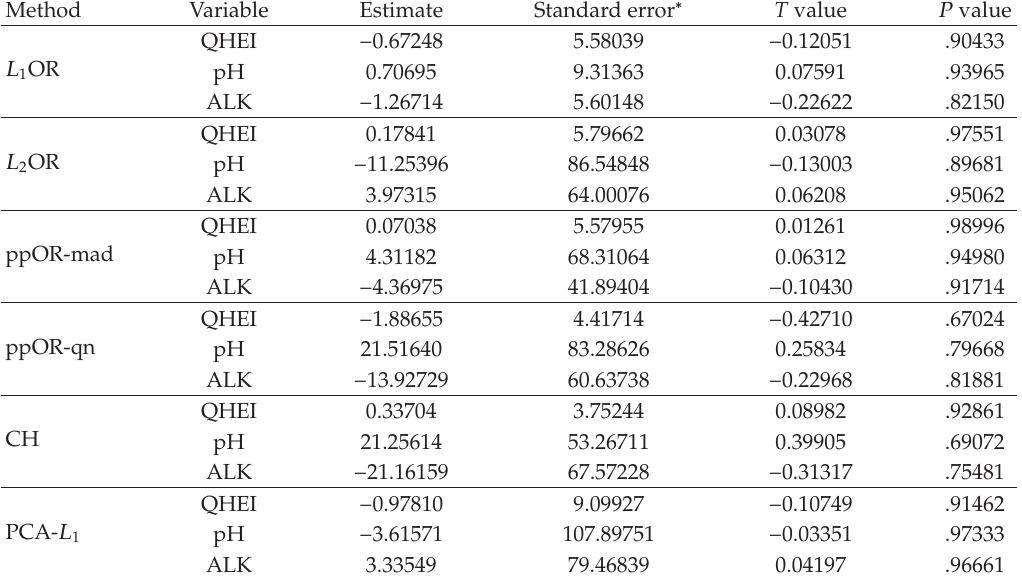
Table 4: Summary of regression models for IBI on QHEI, pH, and alkalinity (cid:2) ALK (cid:3) using L 1 OR, L 2 OR, ppOR-mad, ppOR-qn, CH, and PCA- L 1